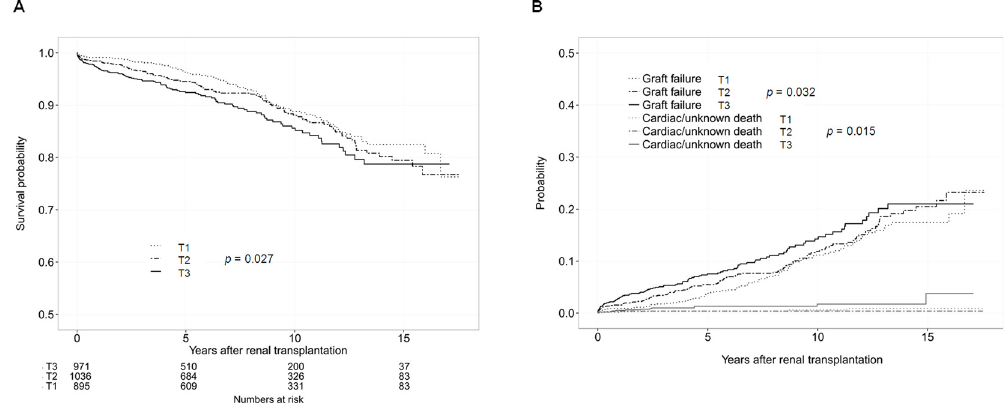
Fig 1. Allograft failure according to the pre-transplant CV risk score before and after adjustment for competing risks. (A) Kaplan-Meier curves for the probability of graft failure in the KT recipients classified by the pre-transplant CV risk score tertiles. (B) Cumulative incidence function for graft failure and competing risk by the pre-transplant CV risk score tertiles. Cardiac death and unknown death were considered competing risk events. T1, the 1 st tertile; T2, the 2 nd tertile; T3, the 3 rd tertile.